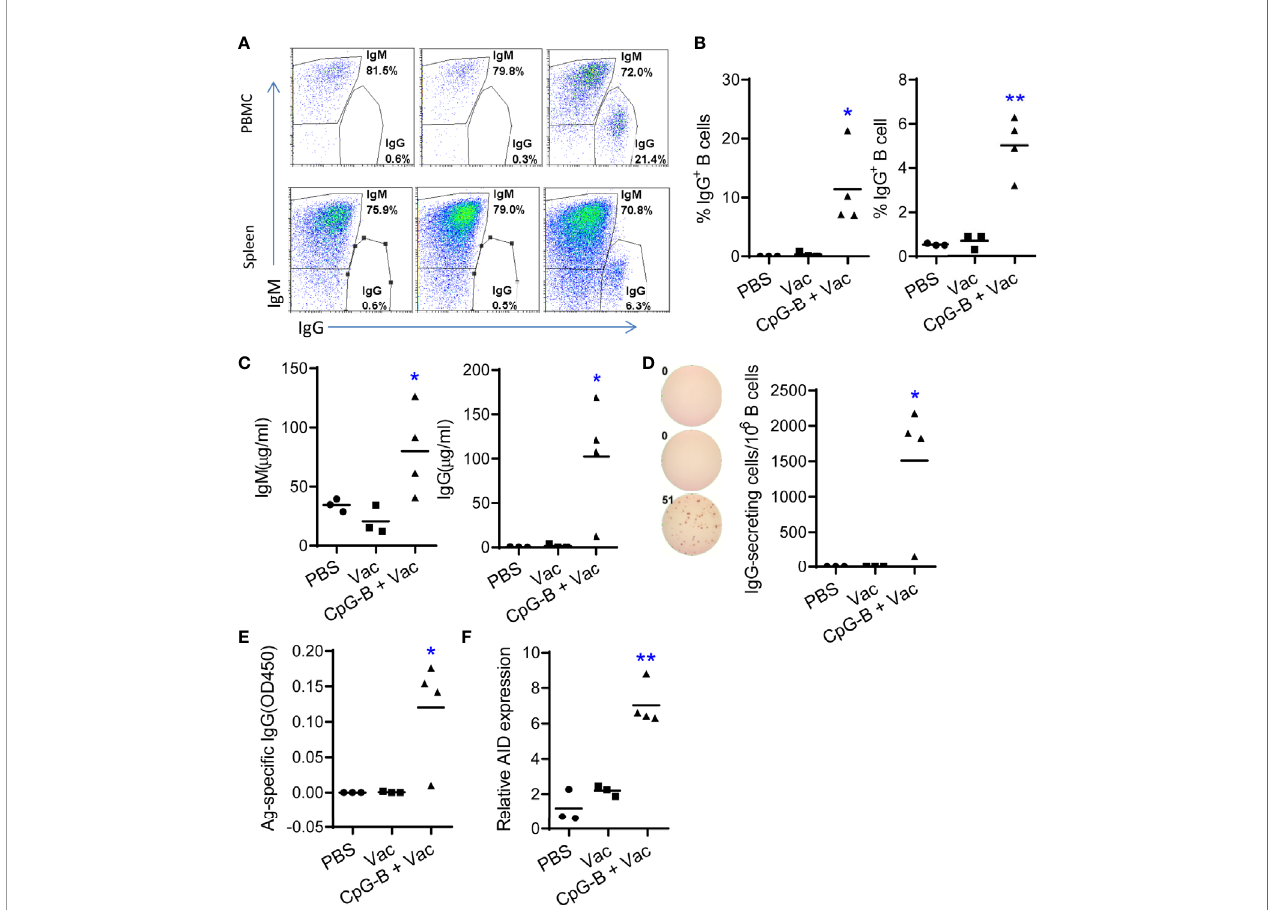
FIGURE 1 | TLR9 agonist CpG-B promotes IgG responses in humanized mice vaccinated with CD40-targeting vaccine. Humanized mice were treated with PBS control (n=3) or vaccinated with a CD40-HIV5pep (n=3) alone or vaccinated with a CD40-HIV5pep plus CpG-B (n=4) at week0, week3 and week6. At week 7, mice were sacri fi ced. (A, B) The expression of IgM and IgG on B cells from PBMCs and spleens was detected by FACS. (C) The total level of IgM and IgG in the plasma was detected by ELISA. (D) Splenocyte from humanized mice were cultured ex vivo in the present of R848(1 m g/ml) and IL-2(10 u/ml) for 48hours, the cells were used for total IgG detection by ELISpot. (E) Antigen speci fi c IgG level in the plasma was detected by ELISA. (F) The expression of activation-induced cytidine deaminase (AID) in spleen cells was detected by RT-PCR. Each dot represents one individual mouse, bars indicate mean. *P < 0.05, **P < 0.01, by unpaired, two- tailed Student ’ s t-test comparing the two vaccinated